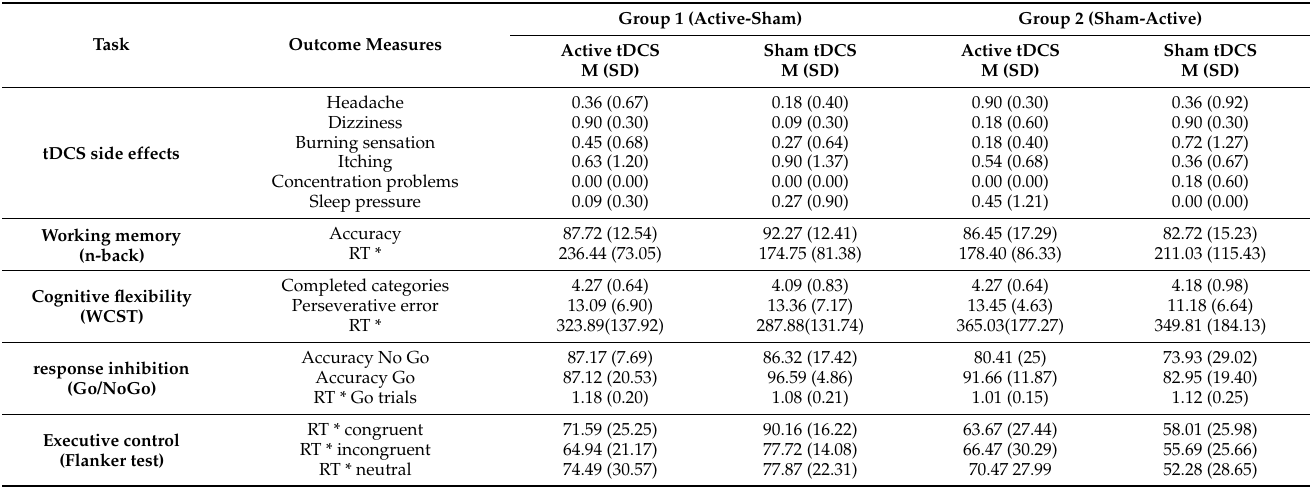
Table 2. Means and SDs of the reported side effects during tDCS, working memory, cognitive flexibility, response inhibition, and executive control task